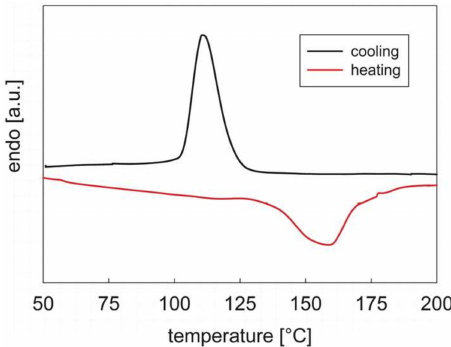
Figure 1. The DSC thermogram of PEOT/PBT between +50 and +200 ◦ C. The cooling/heating rate is 10 ◦ C/min. The cooling after the first heating and the second heating curves are